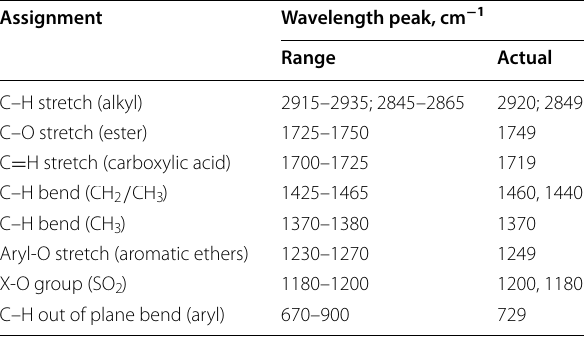
Table 11 Main peak of the FTIR spectrum of biodiesel and their